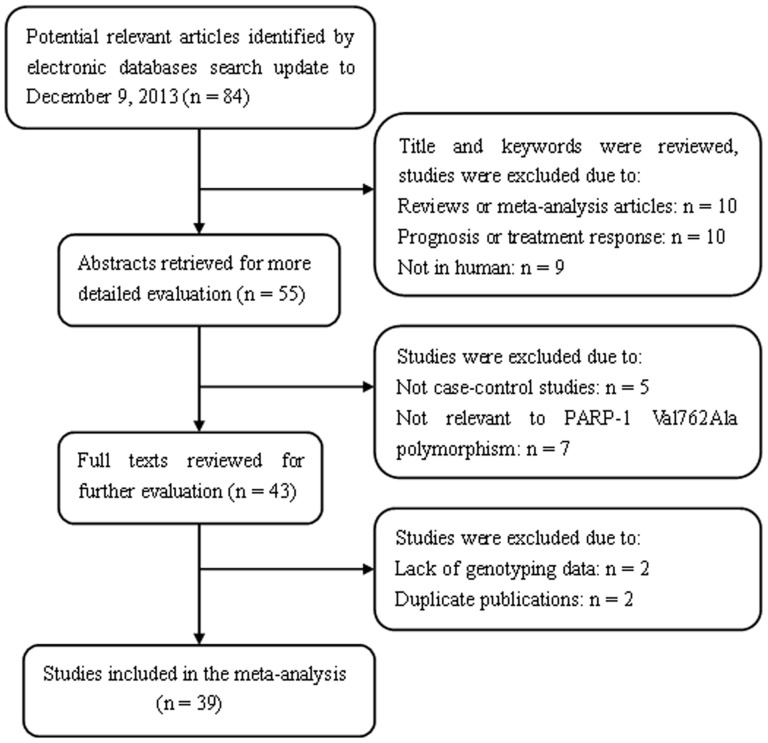
Flow chart of literature search and study selection.